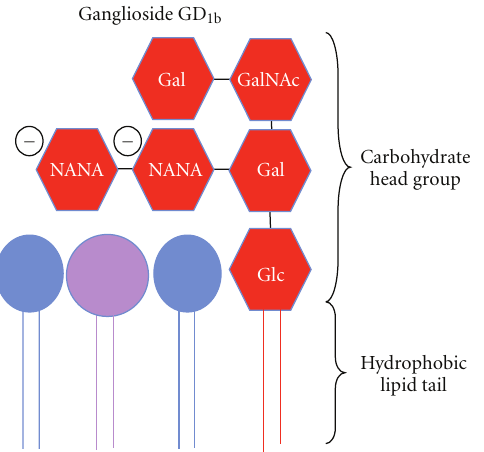
Figure 2: Diagrammatic representation of ganglioside GD 1b . The ganglioside is composed of a carbohydrate head group and a hydrophobic lipid tail.